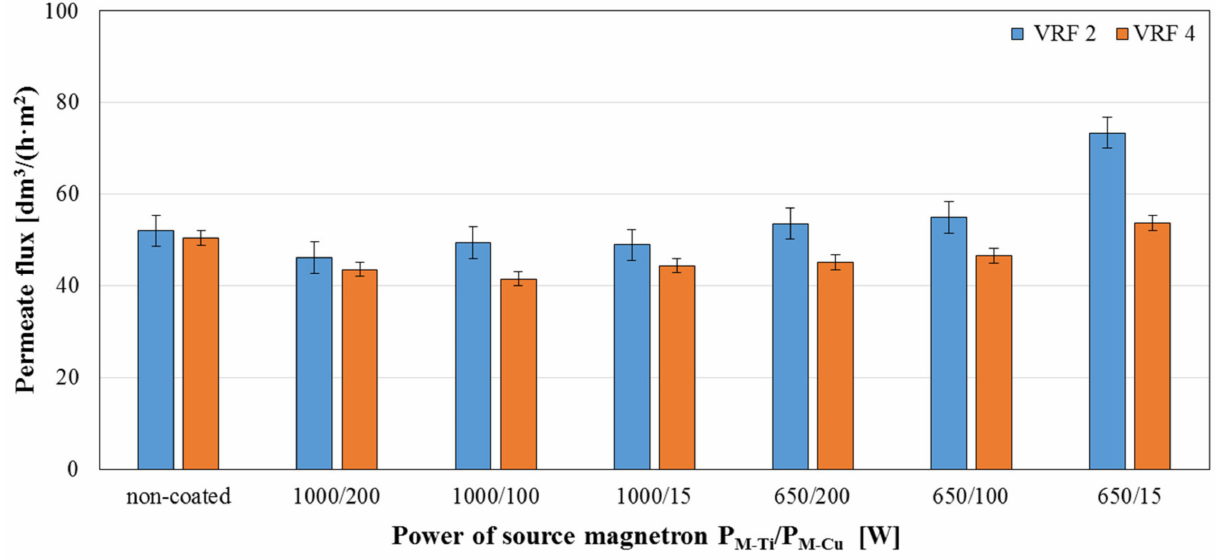
Figure 12. Permeate fluxes determined for 2-fold (VRF 2) and 4-fold (VRF 4) reduction in the volume of the model dairy wastewater in the filtration processes using a non-coated membrane and membranes with deposited TiO 2 + CuO